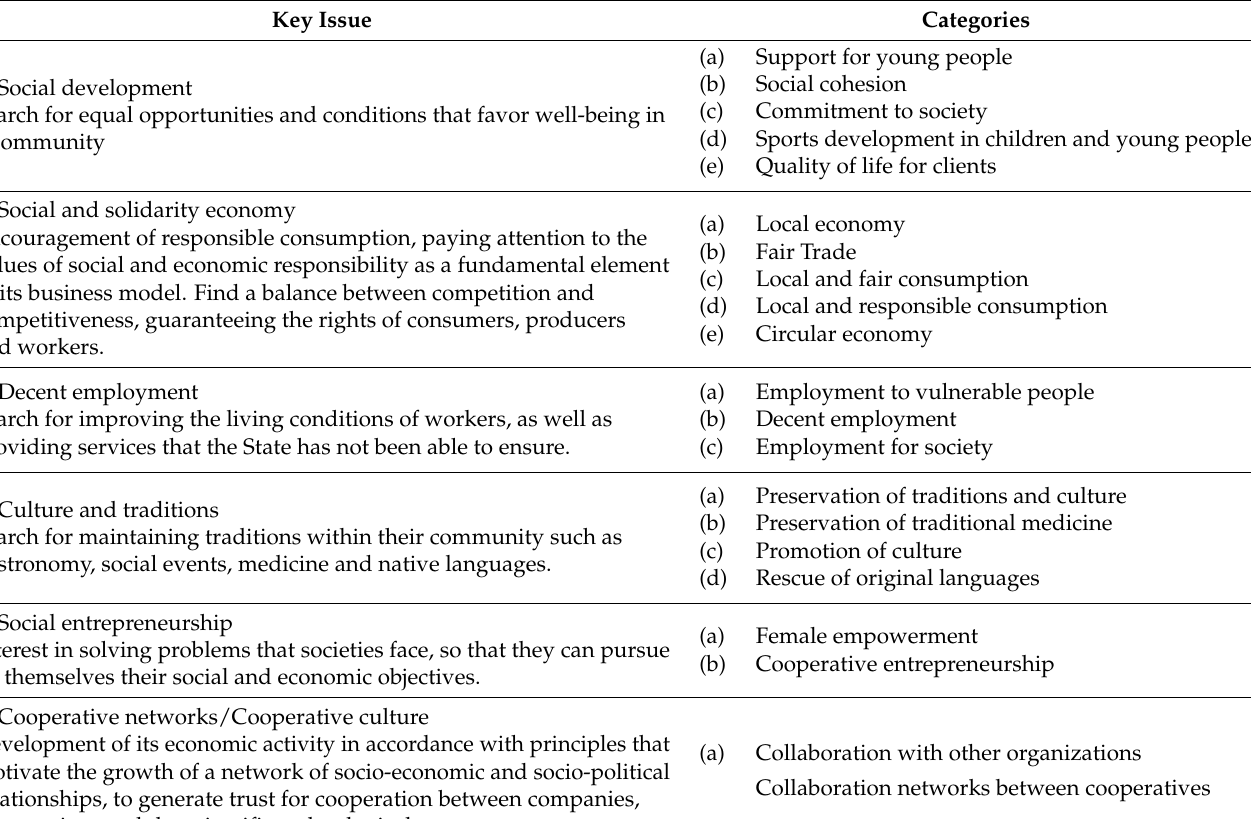
Table 2. Categorization